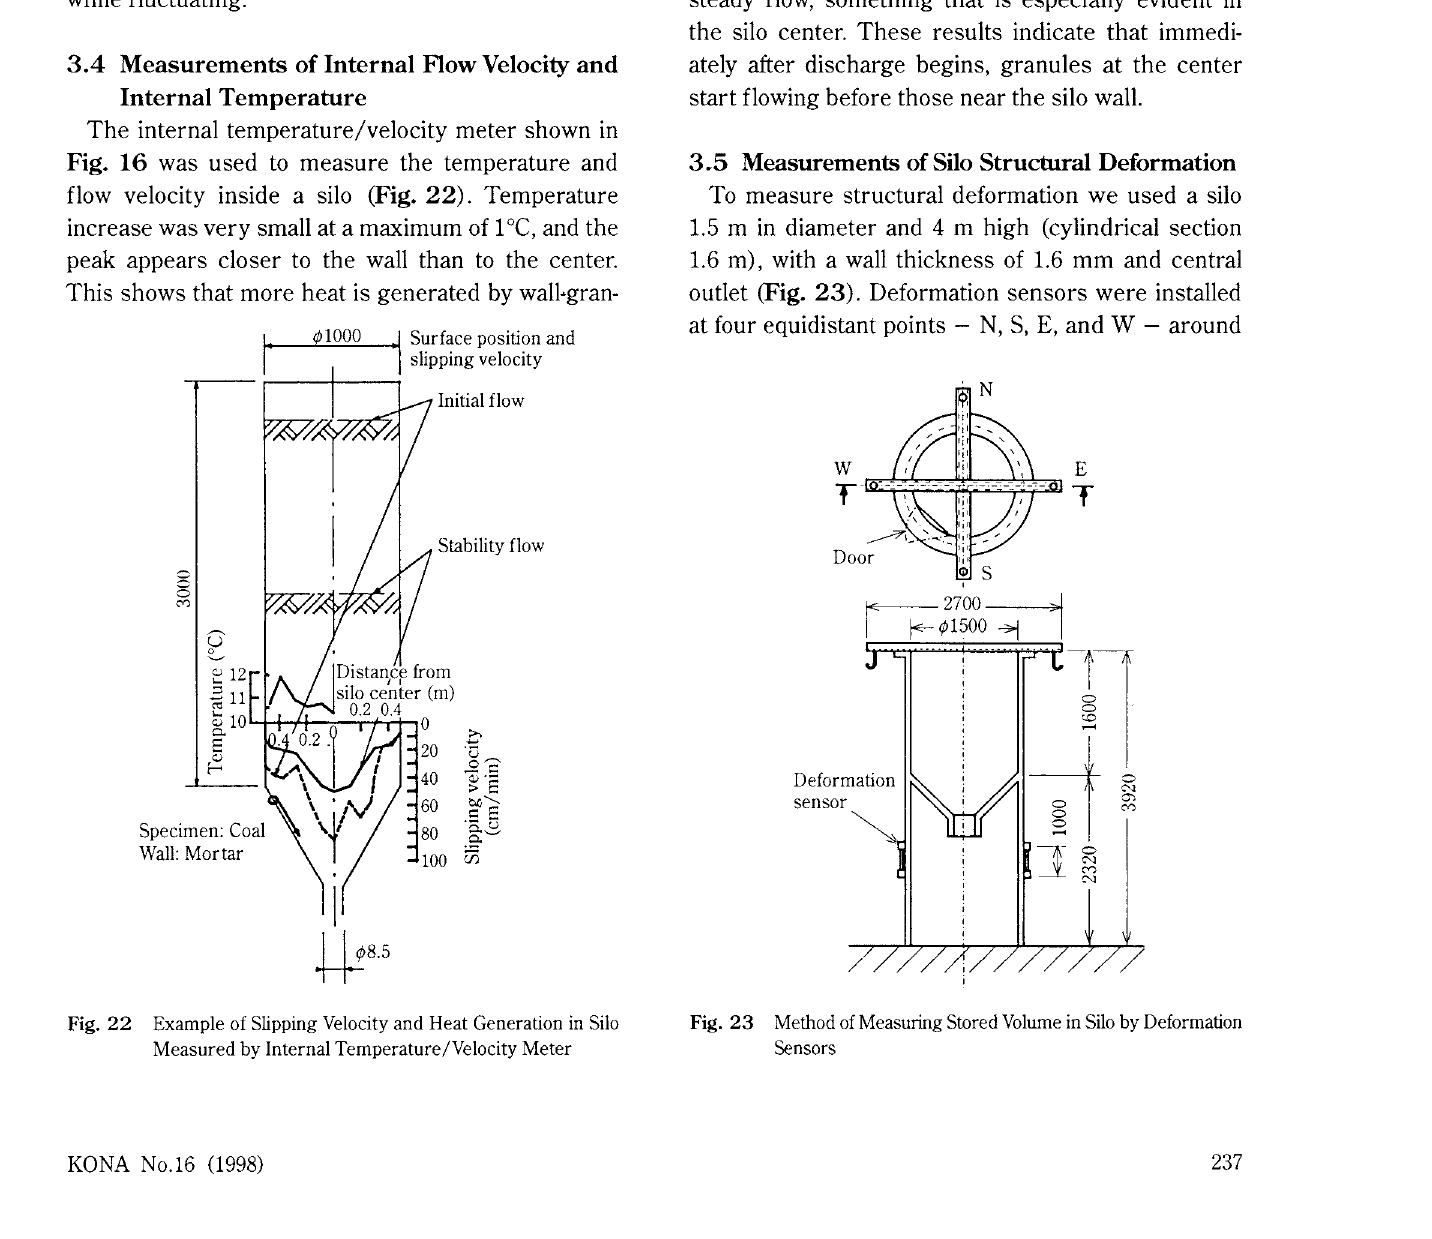
KONA No.16 (1998)